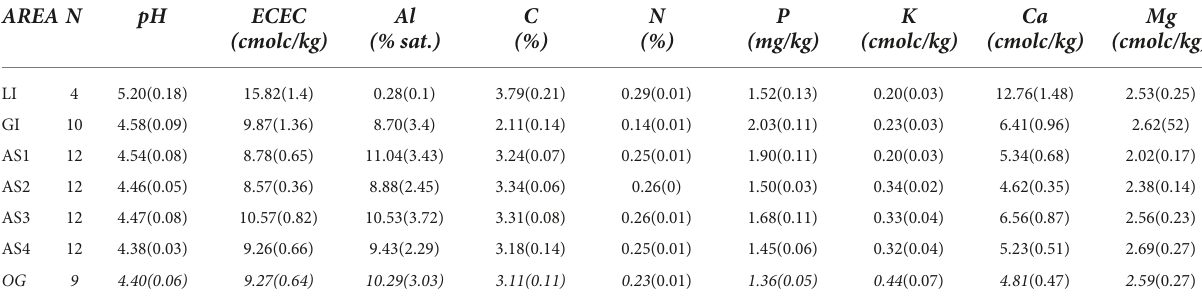
TABLE 1 Mean ( SE ) soil characteristics for all study planting areas: two located in private teak plantations (LI, Limon; GI, Giral), four located within the Agua Salud research site (AS 1–4); and the open-grown pasture comparison area (OG, italics). AREA